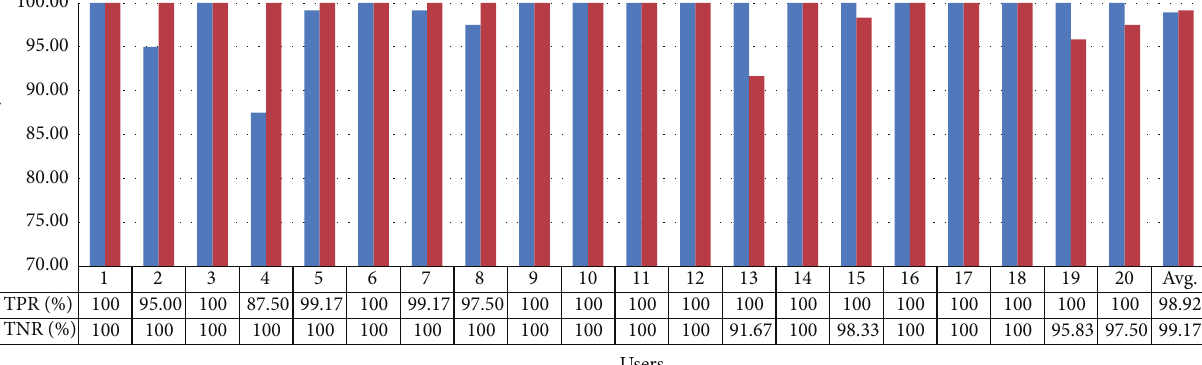
Figure 22: Accuracy of selecting the air conditioner switch using gaze estimation method